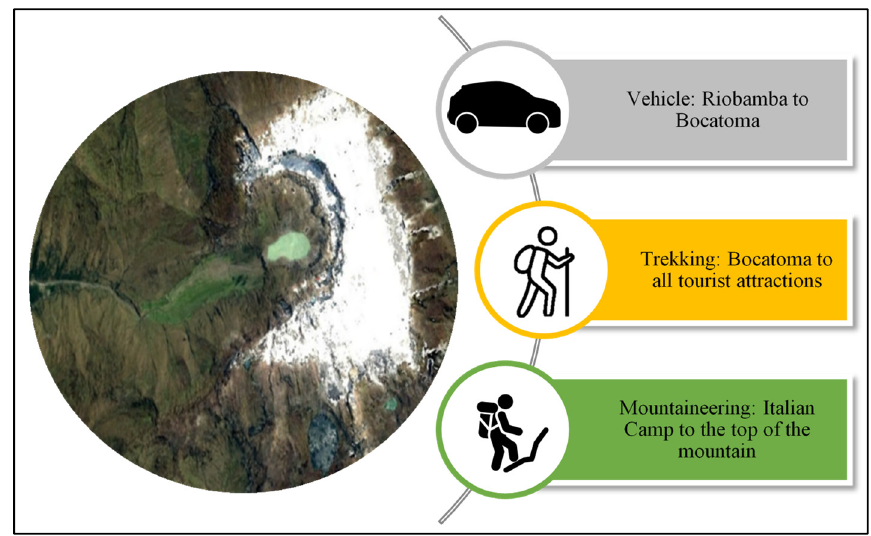
Figure 5. General information of the route.